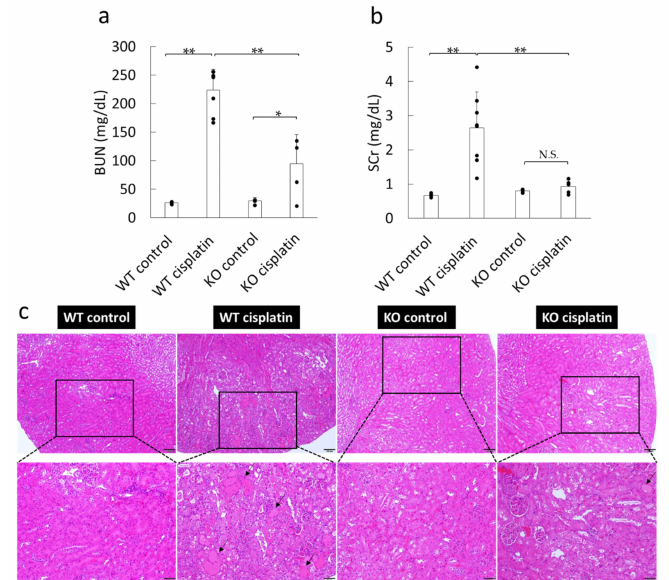
Figure 2. Effect of cisplatin treatment on kidney function and damage in WT and Sult1a1 -/- (KO) mice: ( a , b ) the effect of cisplatin treatment on ( a ) BUN and ( b ) serum creatinine, where each column represents the mean ± S.D. of 4–8 mice, * p < 0.05, ** p < 0.01, and N.S. represents not significant, and ( c ) the effect of cisplatin treatment on kidney tissue histology (hematoxylin and eosin (HE) staining). The arrows indicate tubular cast deposition. Scale bar, 100 µ m ( up ), 50 µ m ( down ).